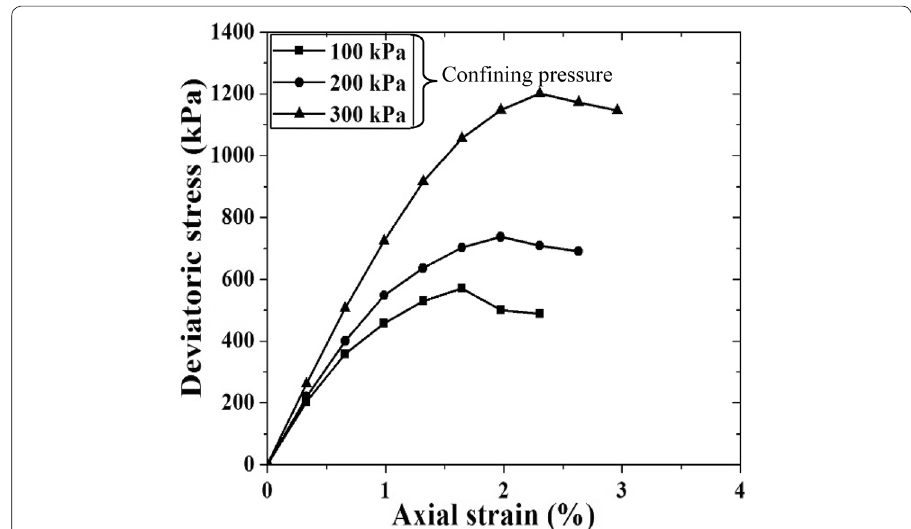
Fig. 18 Stress strain behavior of KTPS fly ash at RC-98%